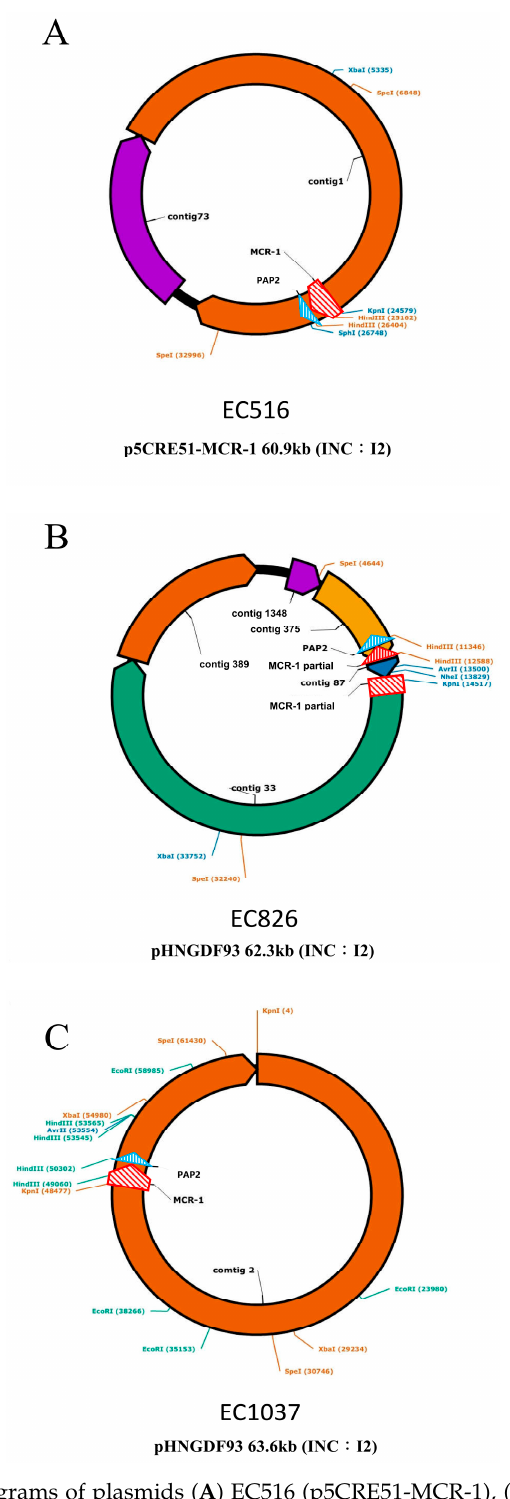
Figure 3. Schematic diagrams of plasmids ( A ) EC516 (p5CRE51-MCR-1), ( B ) EC826 (pHNGDF93), and ( C ) EC1037 (pHNGDF93).